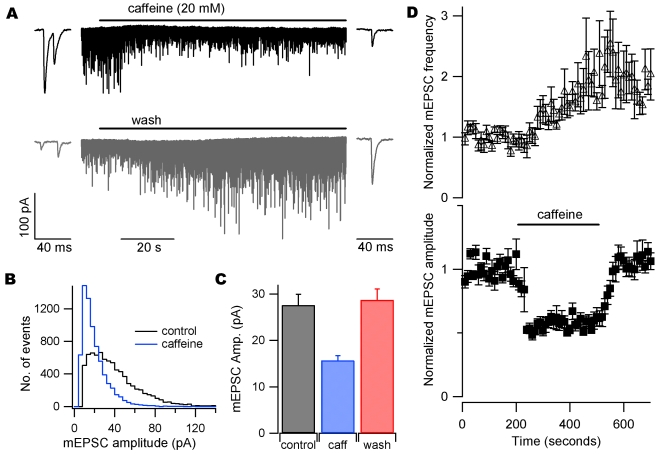
Caffeine reversibly decreases mEPSC amplitude.(A) Recording of mEPSCs in whole-cell voltage-clamp in the presence of TTX (1 µM). Caffeine (20 mM) caused a clear reversible decrease in mEPSC size. The fast rise and exponential fall of synaptic currents was clear throughout recording (insets). (B) Amplitude histograms of events in A 200 seconds immediately before caffeine (black) and during the last 200 seconds of caffeine application (blue). (C) Average mEPSC amplitudes for seven cells before (black), during (blue), and after (red) caffeine application. (D) Normalized average diary plots of mEPSC frequency (top) and amplitude (bottom), n = 7. Bin size = 10 seconds. Each point is normalized to the average of 200 seconds of data recorded before drug application.